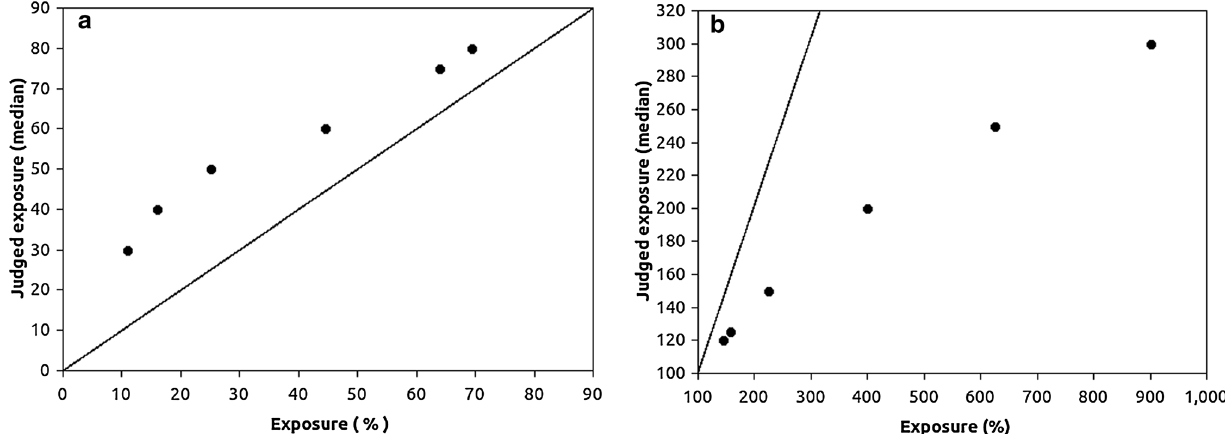
Fig. 1 Median judged exposure in percent after having moved away from a person plotted against model predictions ( a ) and after having moved closer to a person ( b ); the straight lines describe VEM